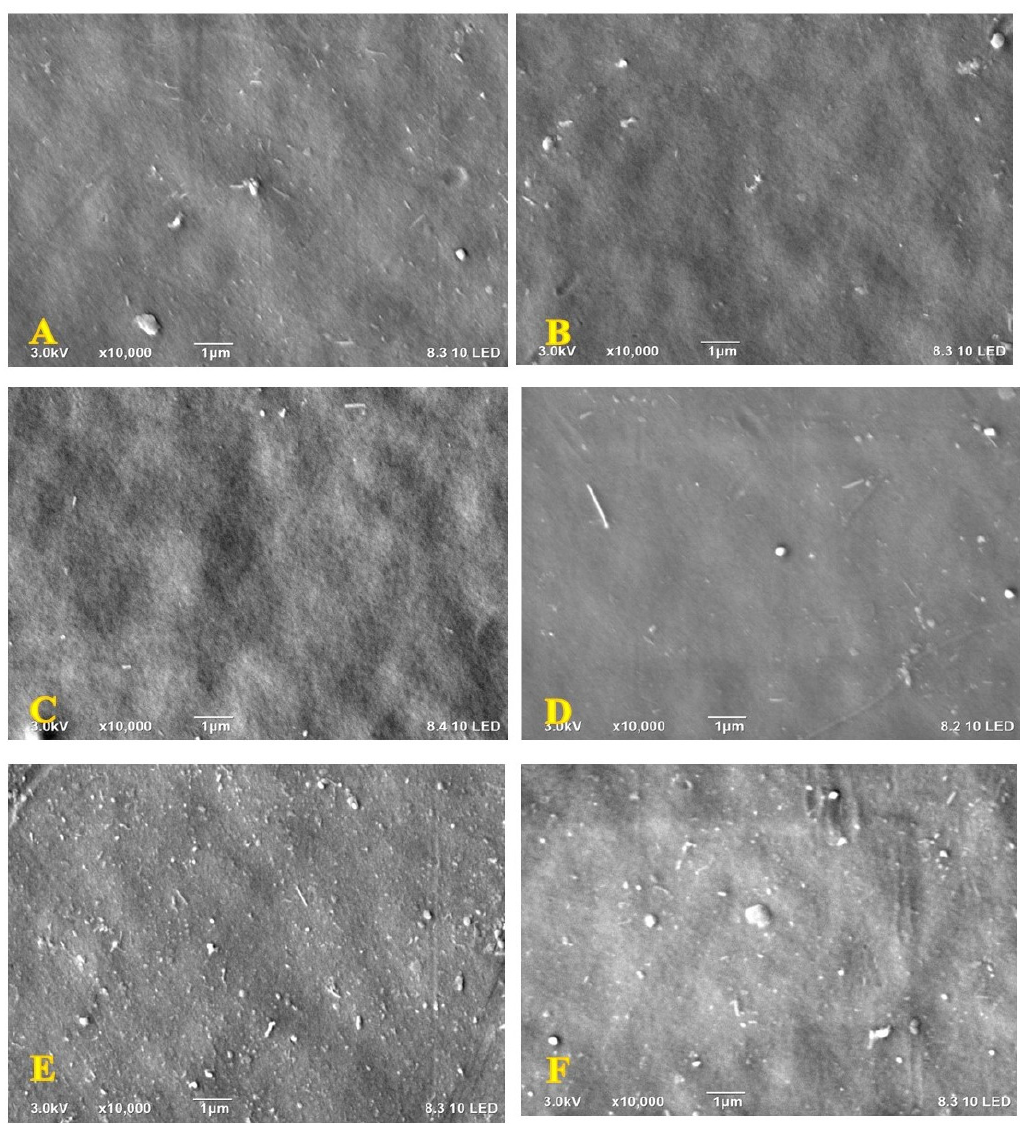
Figure 1. Microscopic images for the surface of ( A ) control PPSU, ( B ) 0.1-M, ( C ) 0.3-M, ( D ) 0.6-M, ( E ) 1-M and ( F ) 1.5-M